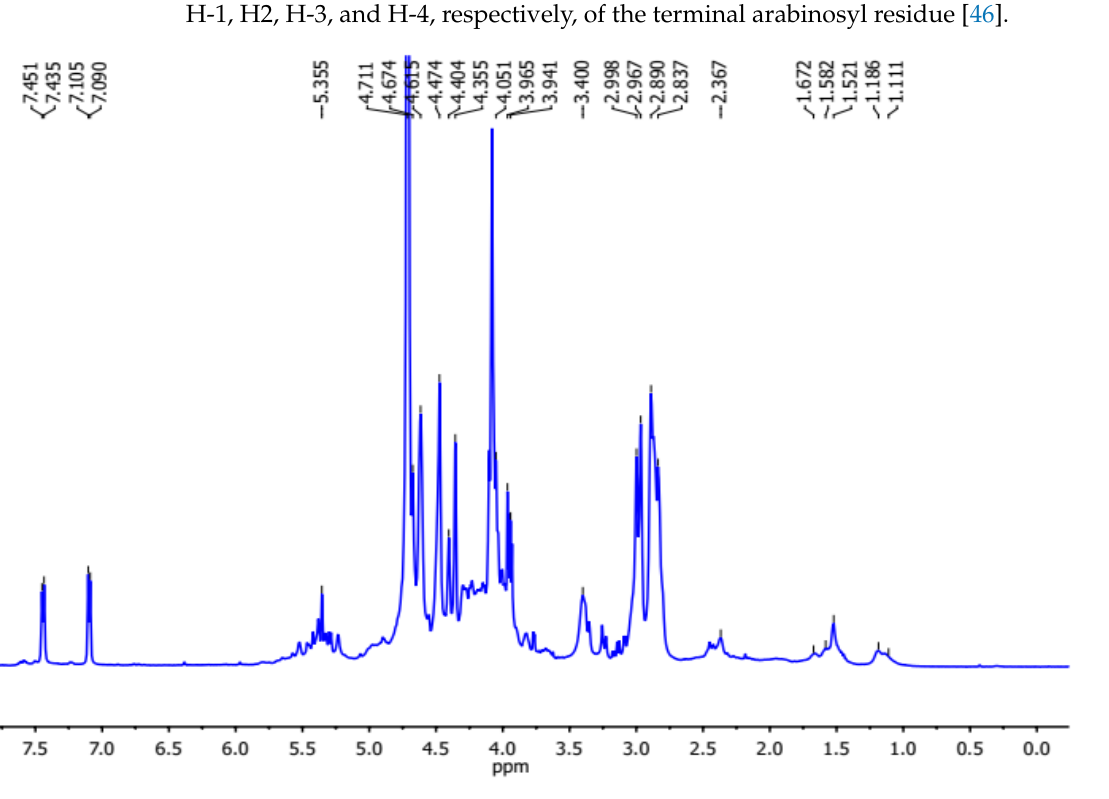
Figure 2. 1 H NMR spectra of CFPS from Clematis flammula .